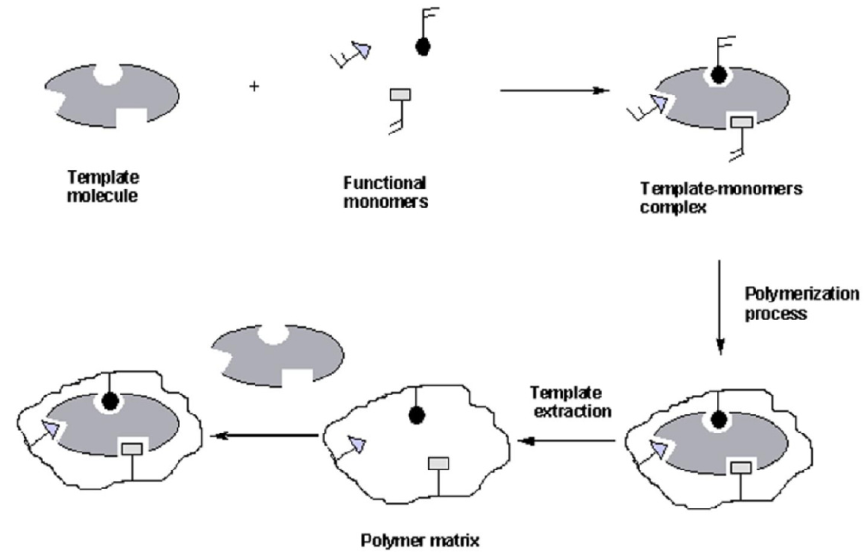
Figure 2. Preparation of molecularly imprinted polymers with functional monomers and a template molecule. Reproduced with permission from [95], Copyright 2011, MDPI